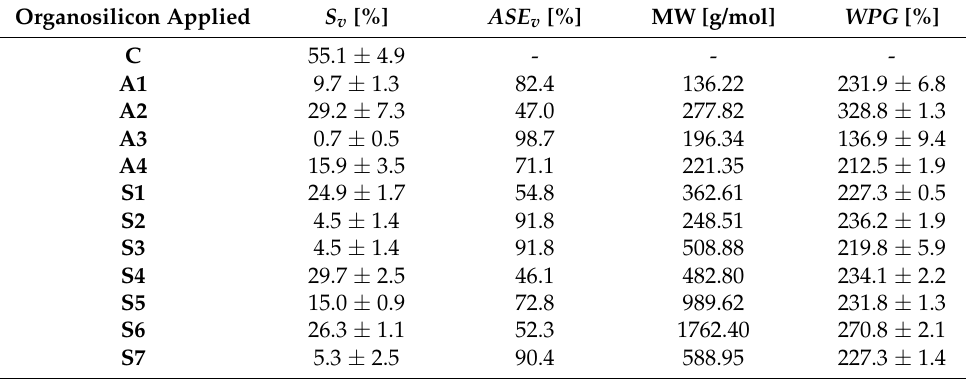
Table 1. The parameters measured/calculated for selected organosilicons or wood samples treated with them: S v , volumetric wood shrinkage; ASE v , anti-shrink efficiency of the individual organosili- con compound; WPG , weight percent gain; MW, molecular weight of an organosilicon monomer; C, untreated waterlogged wood used as a control; the full names of organosilicon compounds are given in Section 4.1